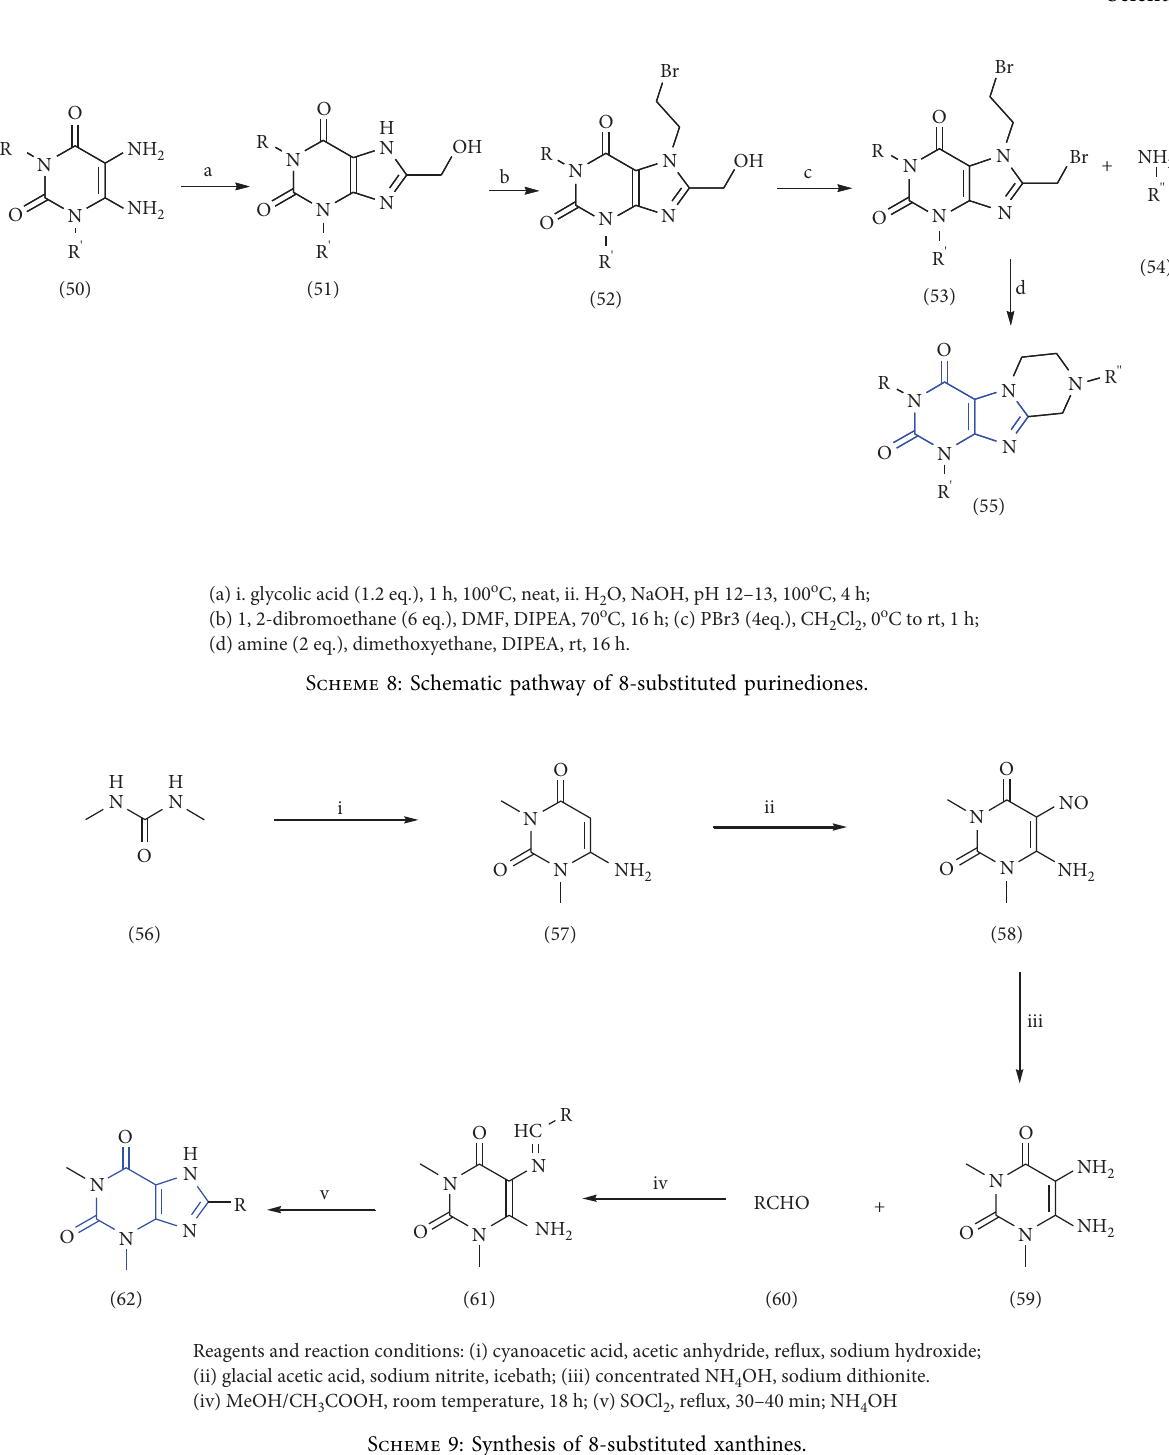
Scheme 9: Synthesis of 8-substituted